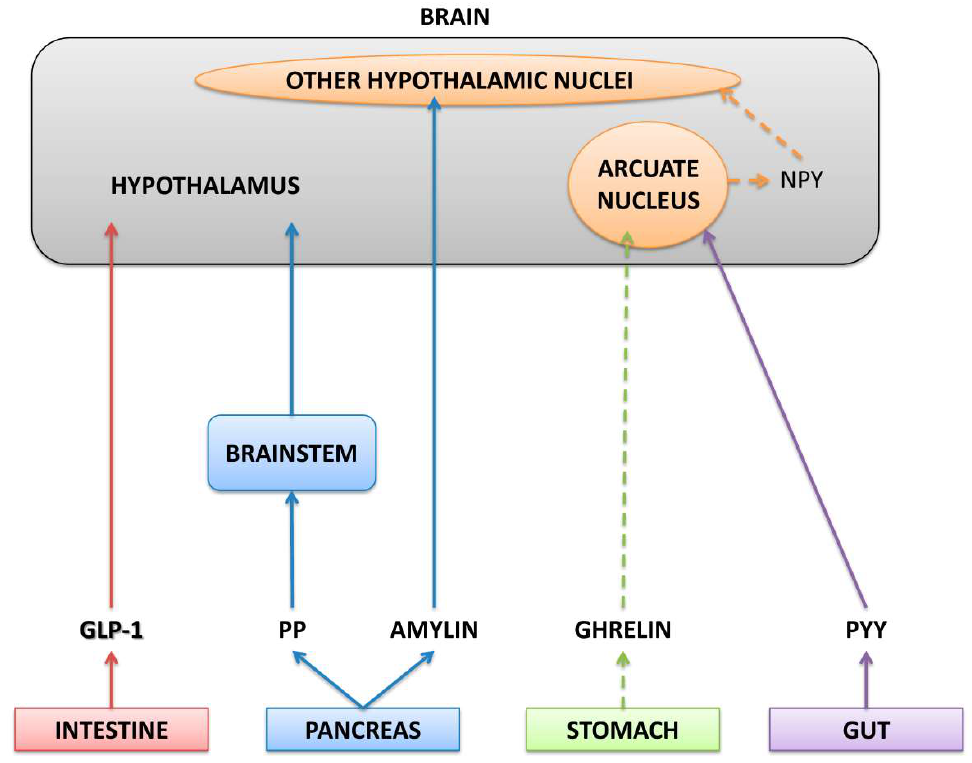
Figure 1. Schematic diagram illustrating neuropeptides. Continuous lines represent anorexigenic peptides that promote satiety; discontinuous lines represent orexigenic peptides that promote hunger. NPY: neuropeptide Y; PYY: peptide YY; PP: pancreatic polypeptide; GLP-1: glucagon-like 1.